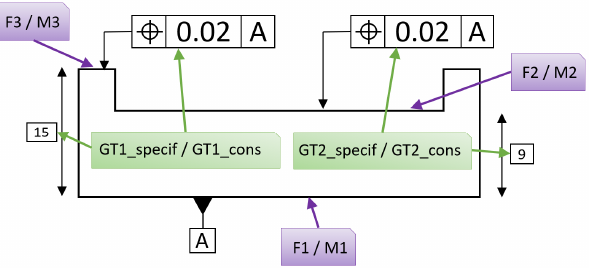
Figure 17. Drawing of the die tool part with specifications for the tolerance analysis.